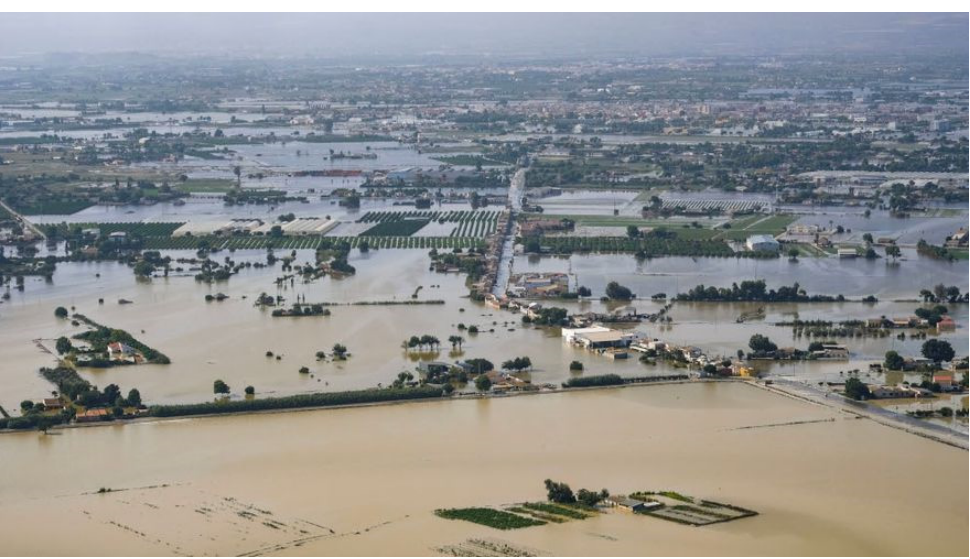
Figure 5. Map of the basic meteorological observation network in Spain. Source: AEMET [65]. 3.2. Increase and Intensity of Drought Episodes With respect to the drought periods, the studies point to an increase in these events [23]. More specifically, since the beginning of the twenty-first century, it has been ob- served that drought periods are becoming more intense and shorter, but, as indicated by Olcina and Biener [24], there are no long drought periods such as those of the second half of the twenty-first century. This reinforces the idea previously indicated of a greater dy- namism in the jet streams at the mid-latitudes of the northern hemisphere, with the more usual expansion of masses of cold air derived from the melting of the Arctic towards lower